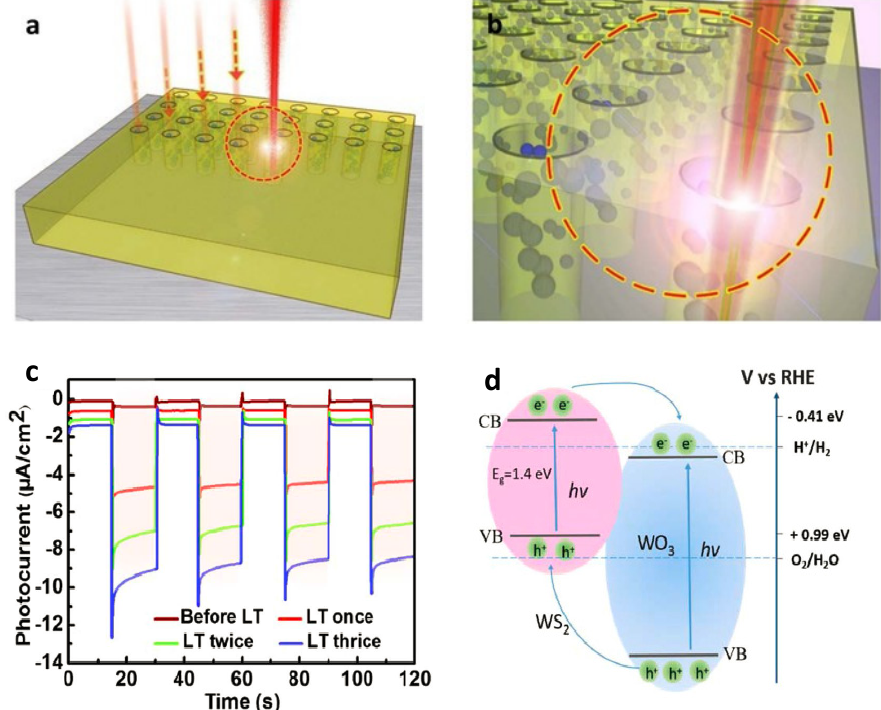
Figure 14. ( a , b ) Schematic illustration of the pulsed laser treatment of the WS 2 sample. ( c ) Chronoamperometry under solar simulator illumination without biasing of WS 2 before and after several laser treatments (LT). ( d ) Schematic diagram of WS 2 /WO 3 heterostructure and their charge transfer under illumination. Reproduced with permission. [149] copyright 2017, Springer Nature.